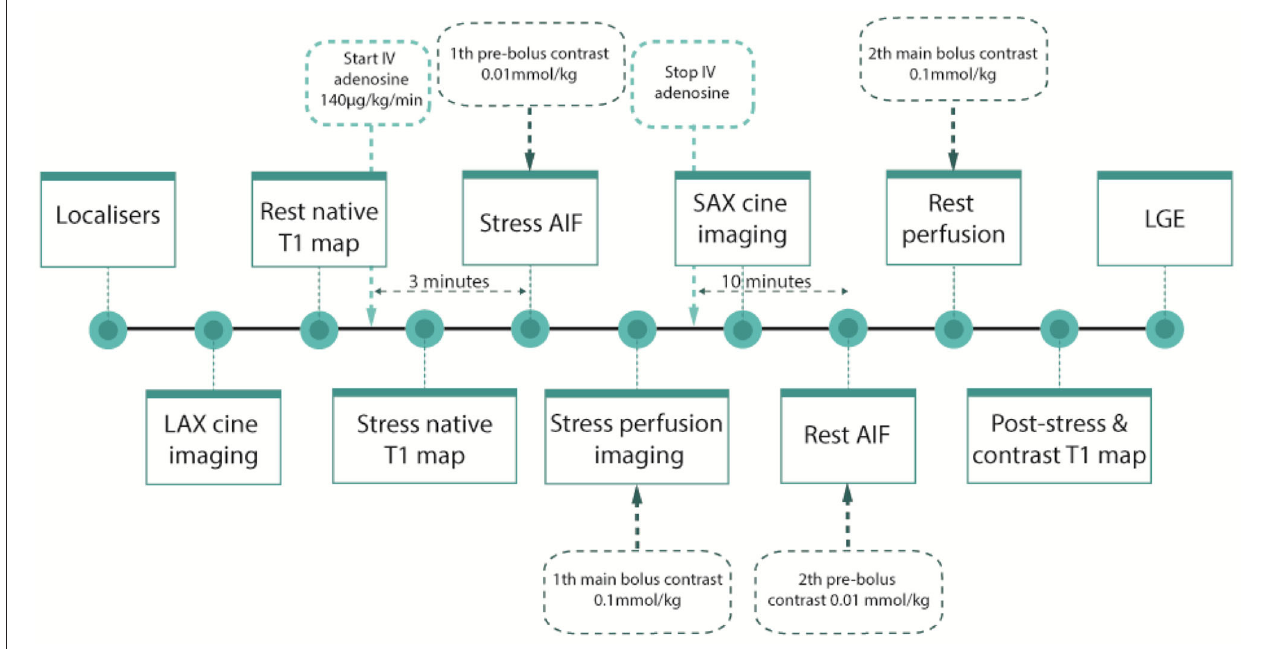
FIGURE 4 | CMR protocol. The CMR-protocol consist of stress- and rest imaging, including long axis cine imaging to quantify left ventricular function, myocardial T1-mapping to quantify extracellular volume fraction, perfusion scans including adenosine stress and rest perfusion scan to quantify perfusion using myocardial perfusion reserve index (MPRi), and late gadolinium enhancement (LGE) imaging which is performed to characterize myocardial tissue together with native T1-mapping. Hyperenhancement with LGE is used to quantitatively assess myocardial infarct scar burden. CMR, cardiac magnetic resonance; LAX, long axis; SAX, Short axis; IV, intravenous; AIF, Arterial input